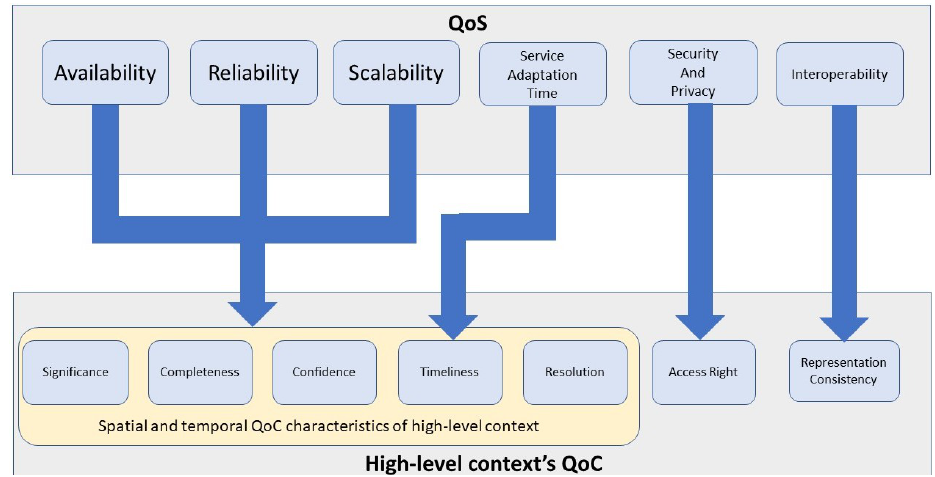
Figure 4. Effect of different QoS metrics (related to processing) on different QoC metrics, where the connecting arrow indicates the